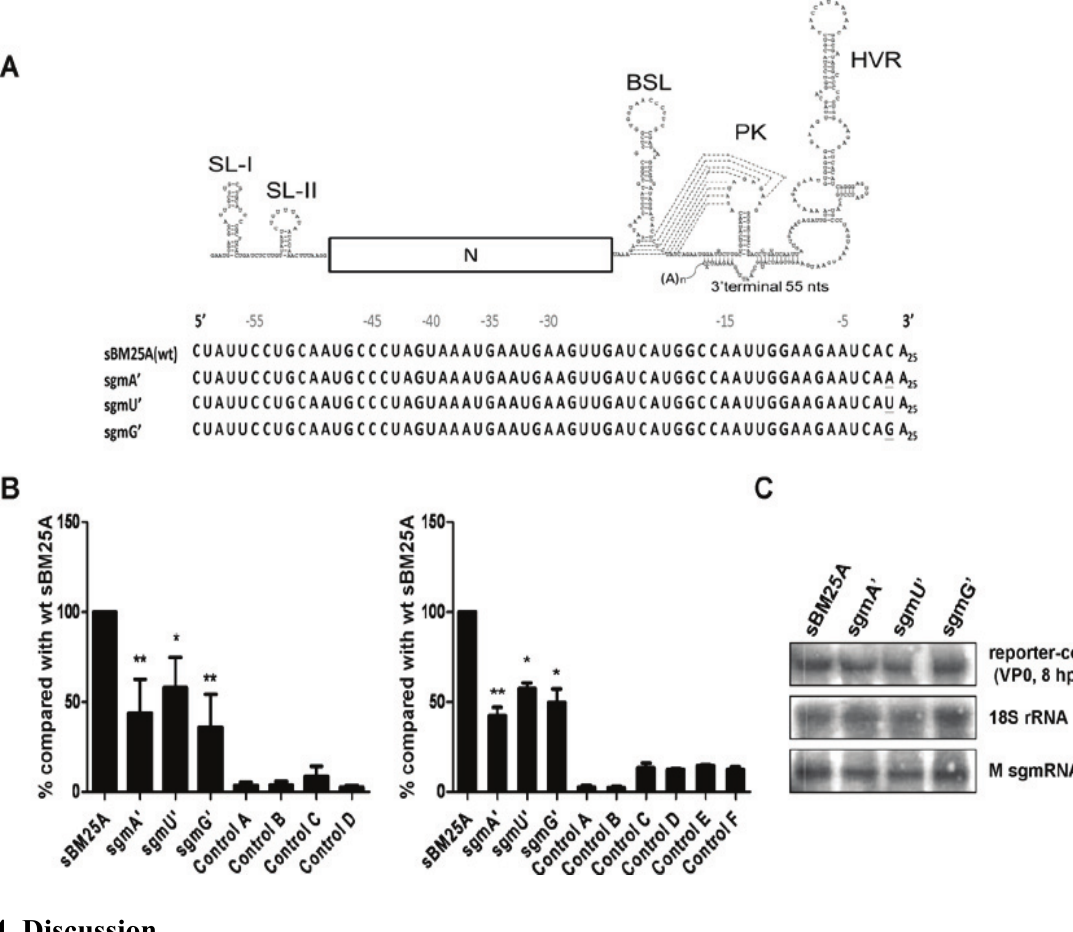
Figure 5. The effect of the 3'-most nt species on the synthesis of ( − )-strand sgmRNA. ( A ) Upper panel: schematic diagram depicting the sgmRNA. Lower panel: constructs with nucleotide substitution at the 3'-most nt of sgmRNA. ( B ) The relative efficiency of ( − )-strand RNA synthesis between the constructs, as measured by RT-qPCR with (left panel) or without (right panel) head-to-tail ligation. Left panel: Control A: total cellular RNA from mock-infected cells. Control B: total cellular RNA from BCoV-infected cells. Control C: total cellular RNA from sBM25A-transfected mock-infected cells. Control D: a mixture of BCoV-infected cellular RNA extracted at 8 hpt and sBM25A transcript. Right panel: Control A: total cellular RNA from mock-infected cells. Control B: total cellular RNA from BCoV-infected cells. Control C: total cellular RNA from sBM25A-transfected mock-infected cells. Control D: total cellular RNA from sgmA’-transfected mock-infected cells. Control E: total cellular RNA from sgmU’-transfected mock-infected cells. Control F: total cellular RNA from sgmG’-transfected mock-infected cells. ( C ) Measurements of reporter-containing sgmRNA, 18S rRNA and M sgmRNA (from helper virus) at 8 hpt of VP0 by Northern analysis. Values (B) represent the mean ± SD of three individual experiments. * p < 0.05, ** p <